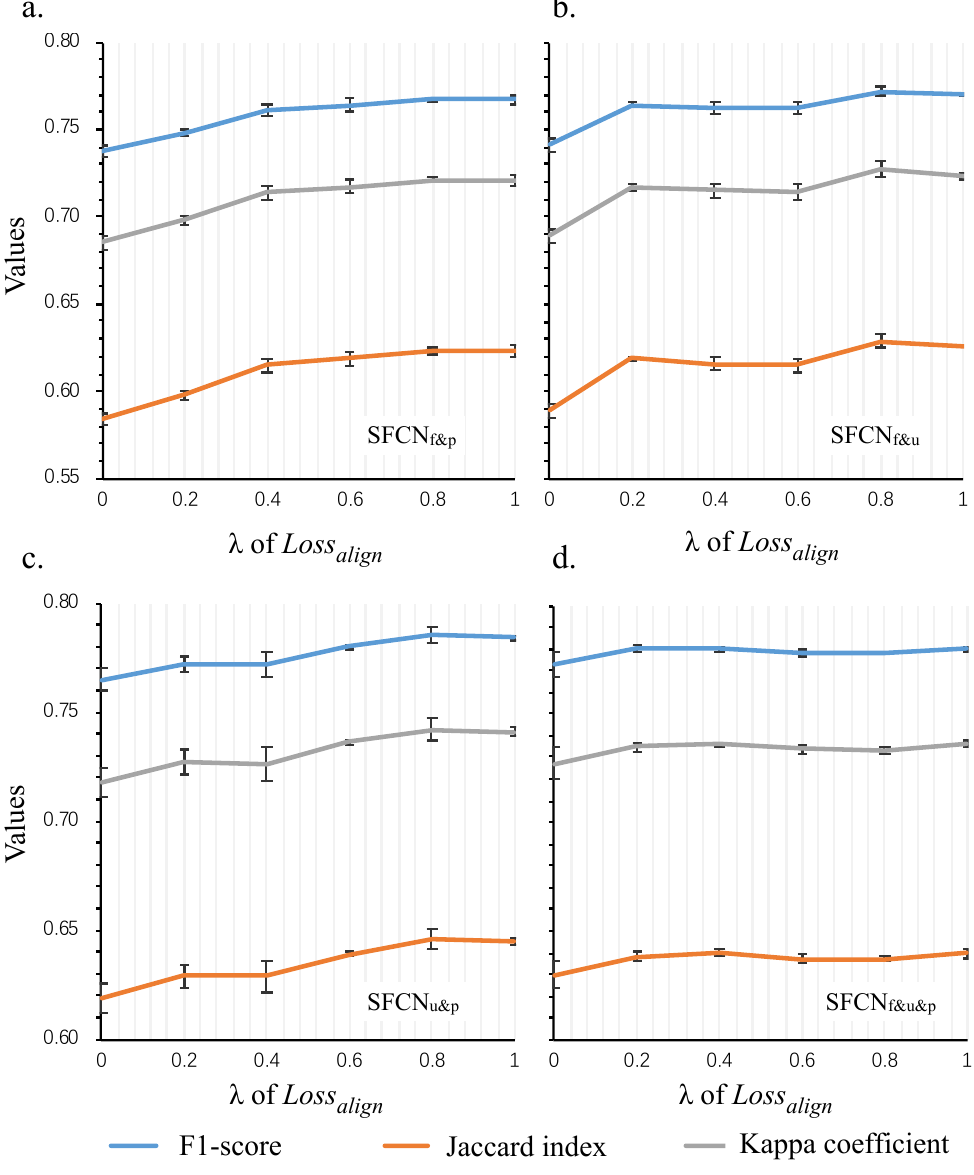
Figure 5. Trends of model performances of four SFCNs using lambda values in [0.0, 0.2, 0.4, 0.6,